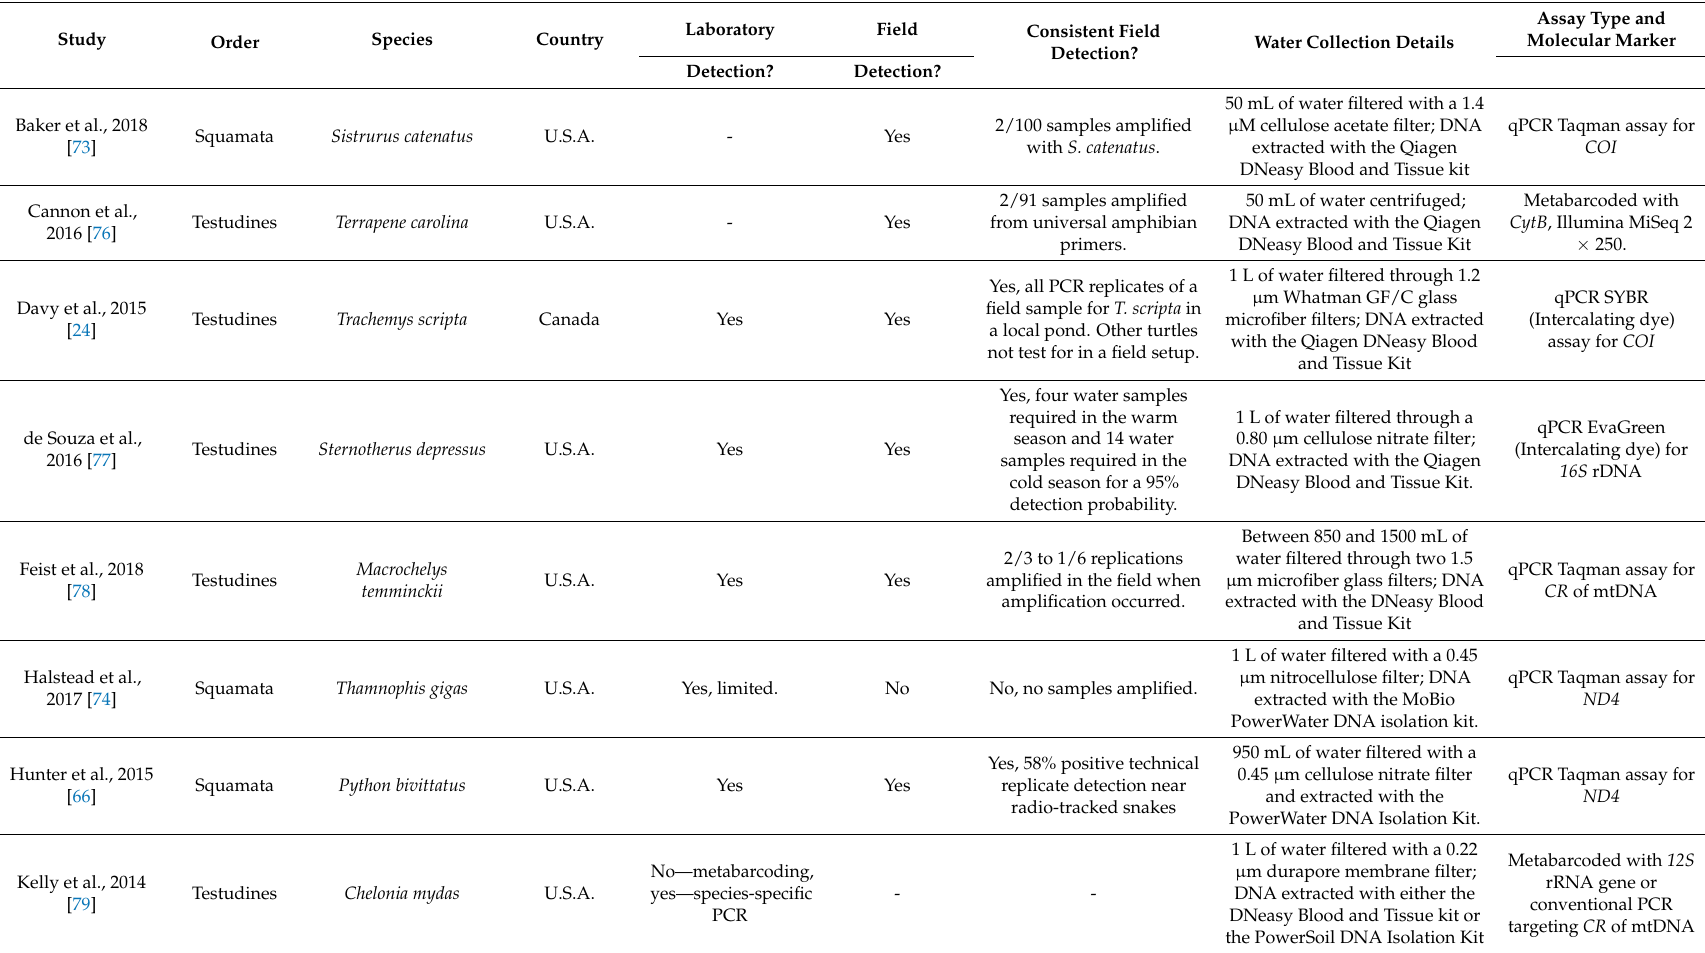
Table 1. Studies that include research on snake or turtle environmental DNA in aquatic